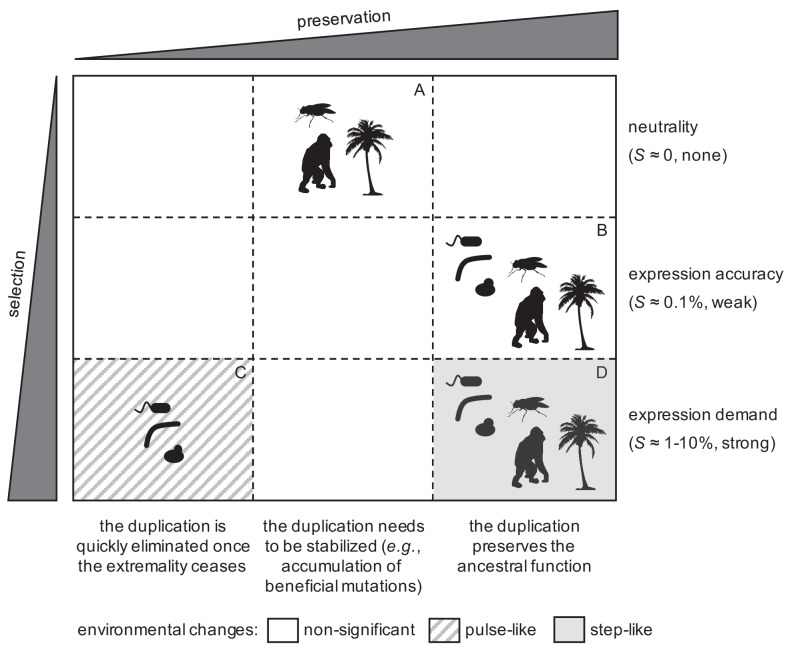
General model to explain the fixation of duplicated genes as a function of the degree of selection in the population and preservation in the genome for long time.Representative silhouettes correspond to bacteria (prokaryotes), yeasts (lower eukaryotes), insects, plants, and mammals (higher eukaryotes).